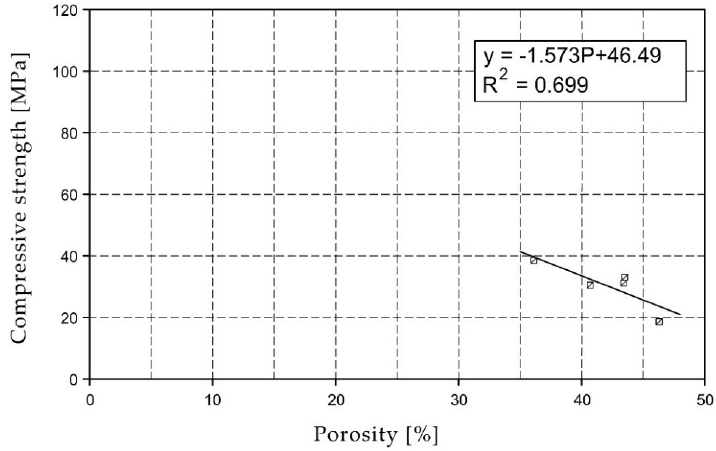
Figure 7. Water absorption coefficient of O01XX series bricks.